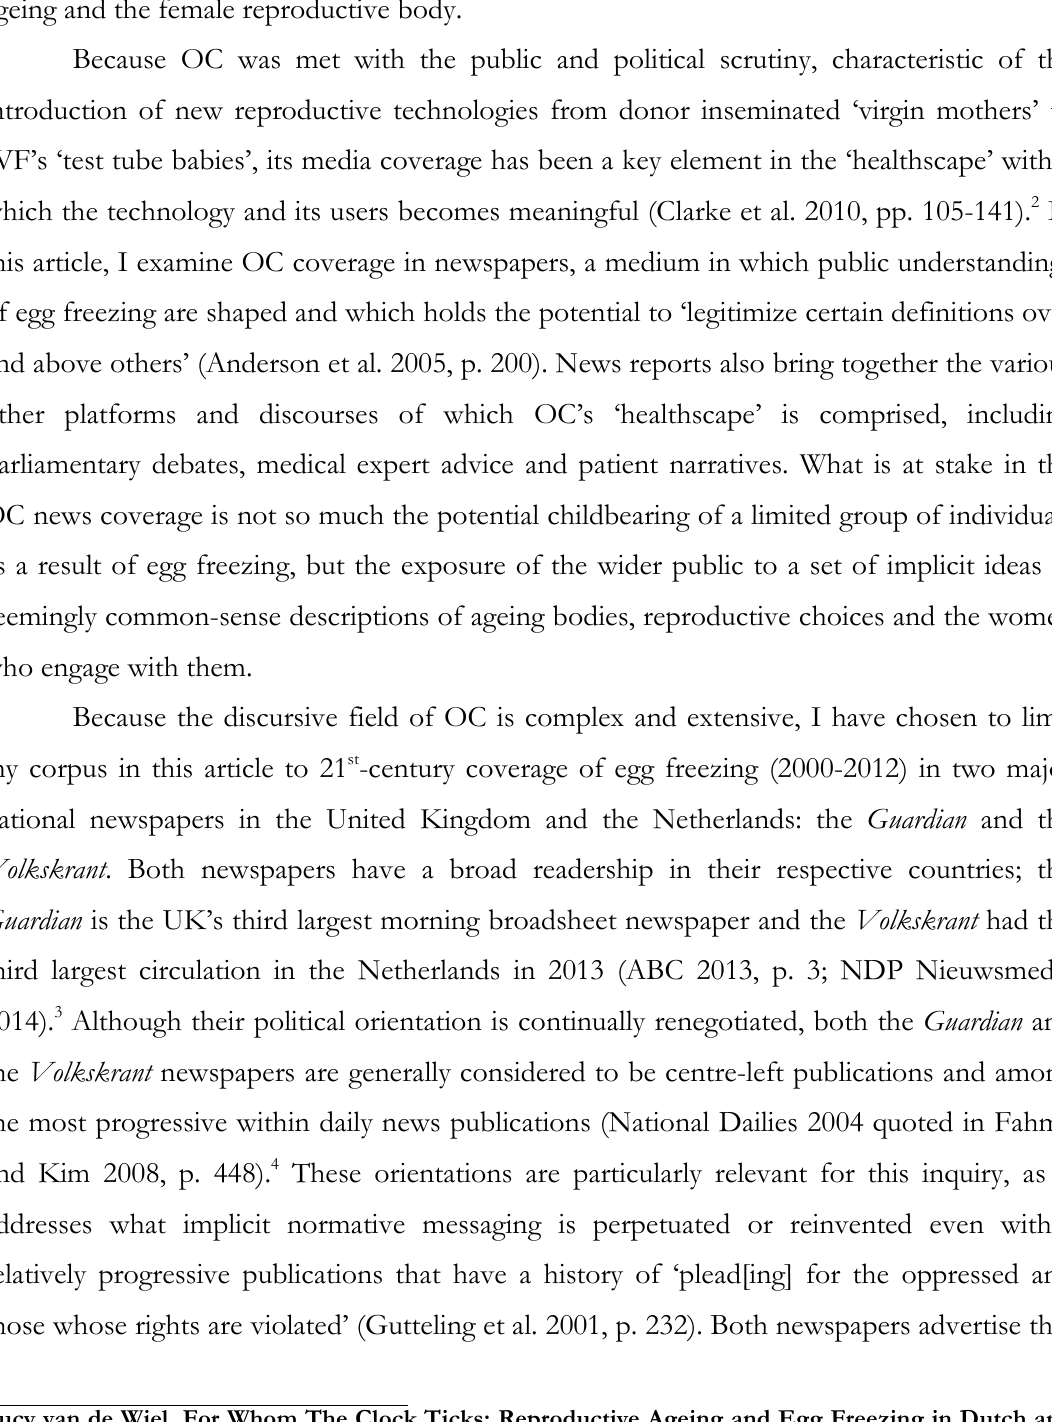
Lucy van de Wiel, For Whom The Clock Ticks: Reproductive Ageing and Egg Freezing in Dutch and British News